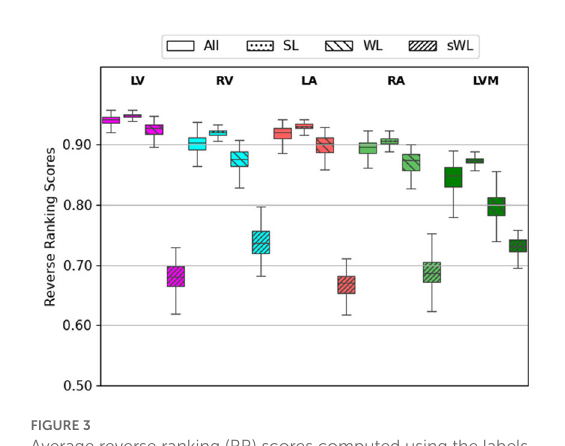
FIGURE3 Average reverse ranking (RR) scores computed using the labels from Computer Label Generator (CLG). RR scores are plotted for each structure with the four datasets in the order of All, strong label (SL), weak label (WL), and synthetic weak label (sWL).